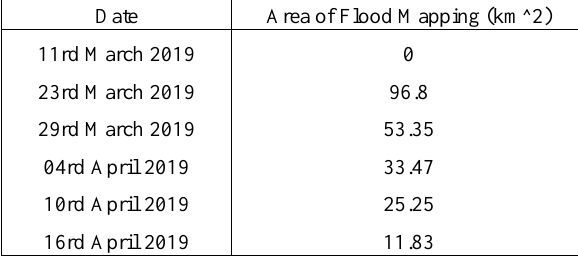
Table 2. Area of Flood Map for time series, Based on initiating of Flood to Mitigation of Flood